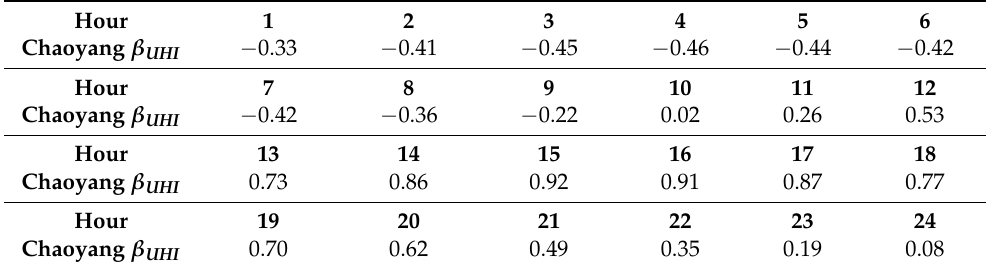
Table 14. Hourly variation coefficient of dry bulb temperature in Chaoyang.